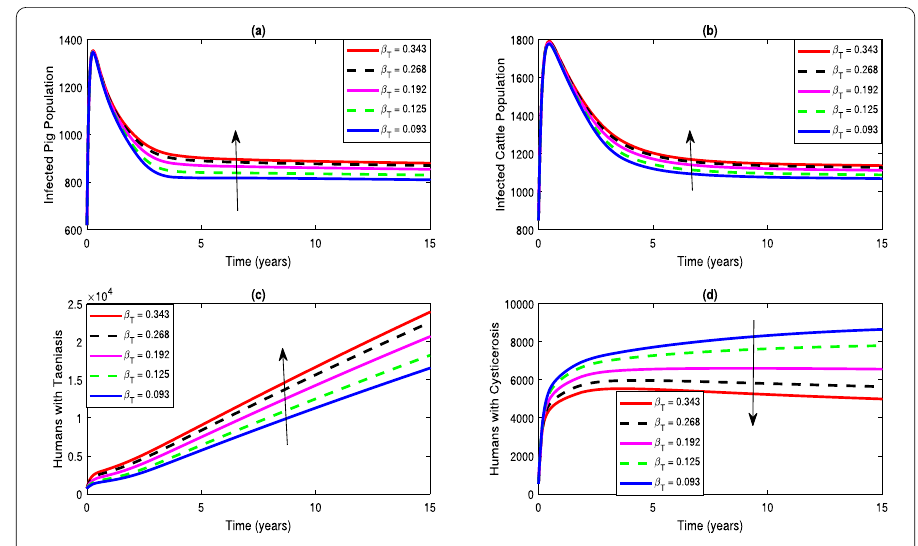
Figure 6 Impact of varying probability of infection on infected